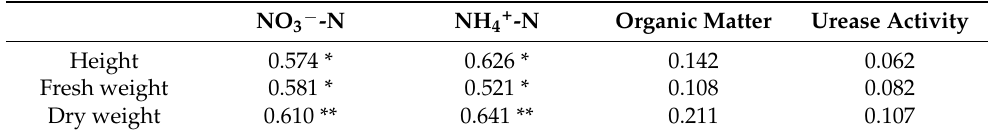
Table 7. Correlation analysis between soil physical and chemical properties and plant growth